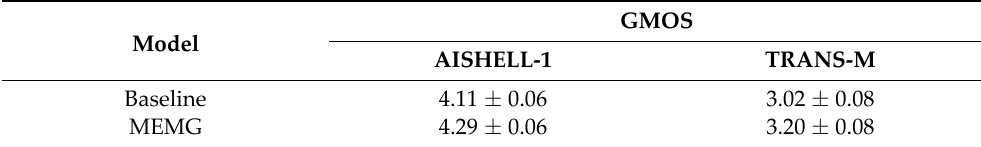
Table 6. The GMOS of the proposed system on two test